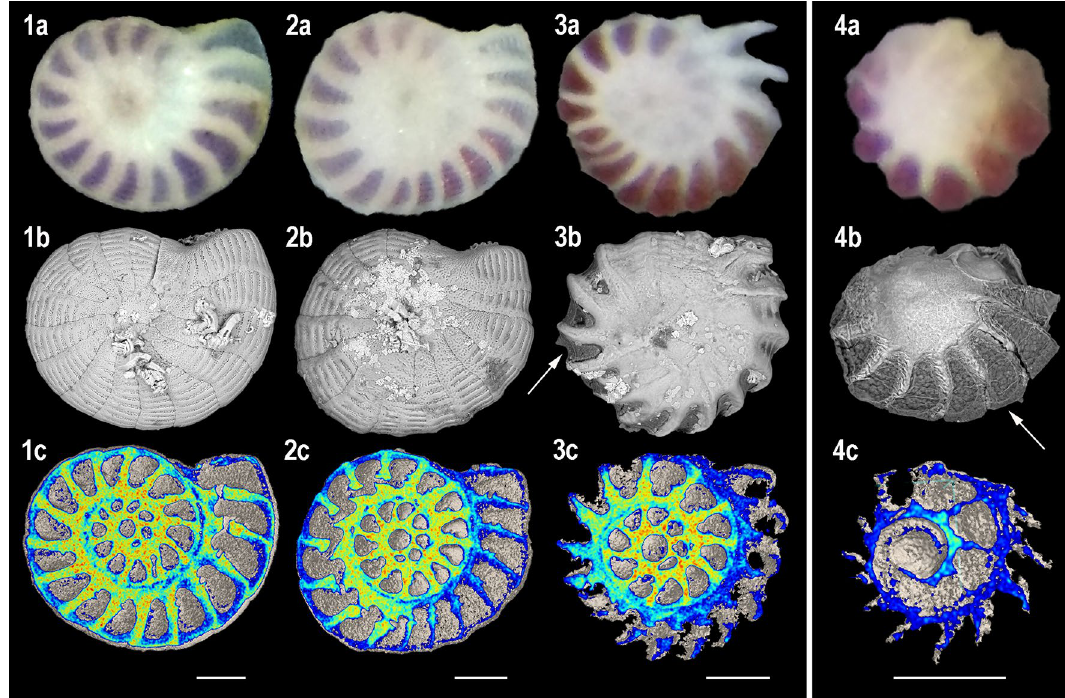
Figure 1. Light micrographs (above), SEM micrographs (middle) and cross-sections (below) of Peneroplis spp. specimens after the decalcification phases. Three days at ( 1 ) pH 7.9; ( 2 ) pH 7.4; ( 3 ) pH 6.9; ( 4 ) 32 days at pH 7.4. Colors are relative densities. Scale bars are 100 µm. Arrows: organic